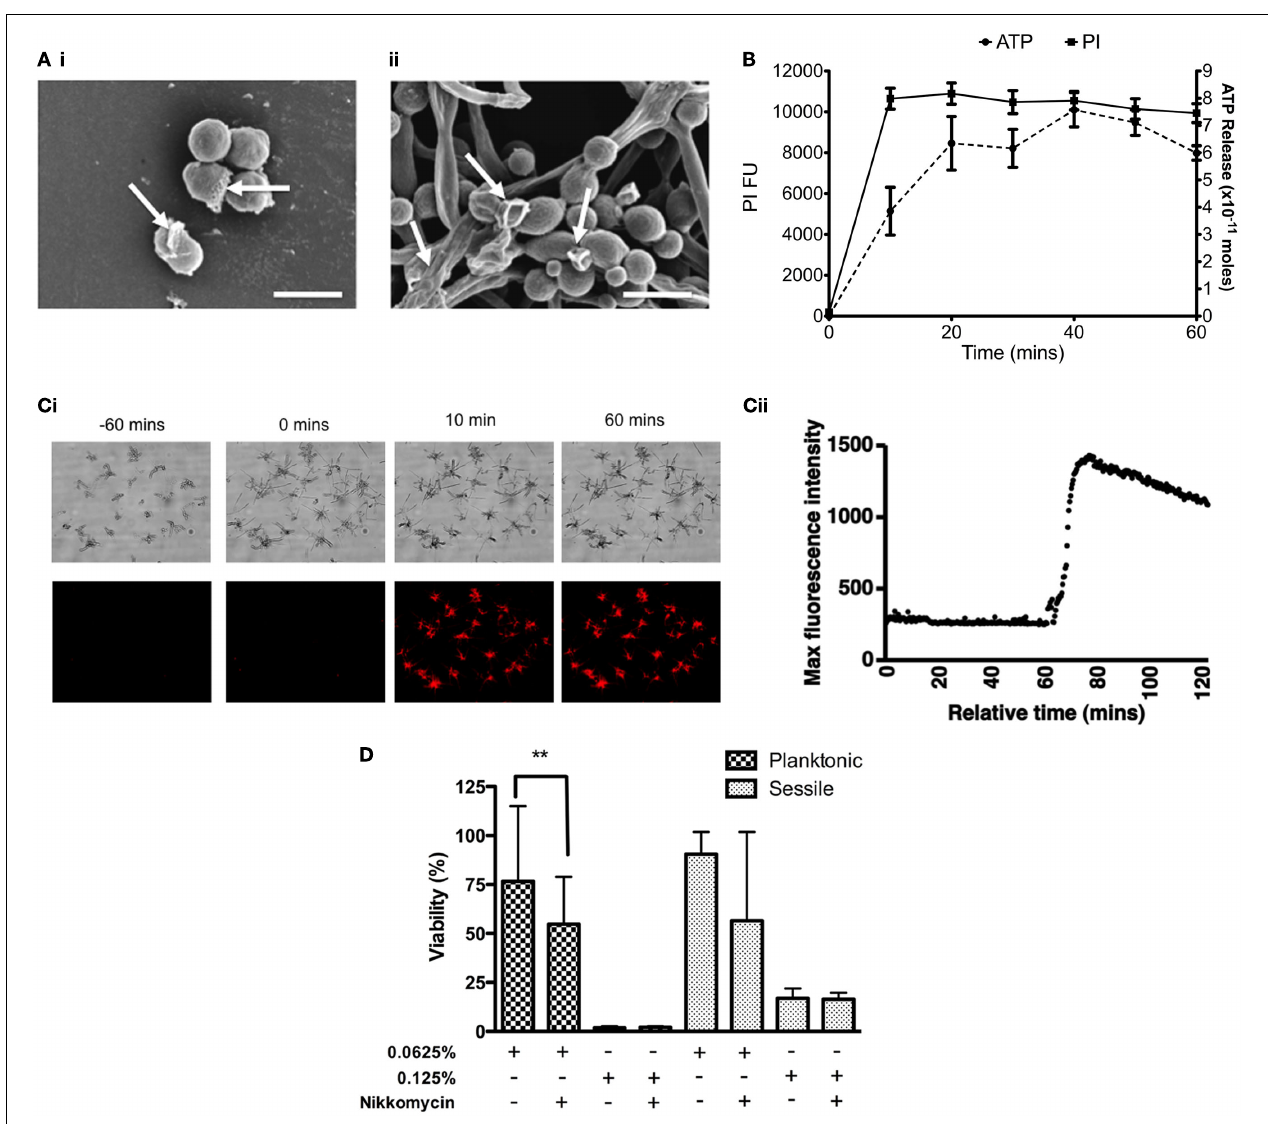
FIGURE 2 | Carbohydrate derived fulvic acid permeabilizes Candida albicans cell membranes. (A) Planktonic cells (i) and sessile (ii) cells were treated at their respective MIC 90 for 24h either in solution or on Thermanox™coverslips, respectively.These were then processed and viewed on a JEOL JSM-6400 scanning electron microscope and images assembled using Photoshop software. Note the apparent disruption of the cell wall denoted by arrows on both the planktonic and sessile cells. Scale bars represent 5 μ m. (B) C. albicans (SC5314) planktonic cells (5 × 10 7 cells/ml) were treated with CHD-FA (4%) for 10, 20, 30, 40, 50, and 60min. A negative control (no CHD-FA) was also included. For PI experiments the cells were washed by centrifugation, resuspended in PI (20 μ M in PBS), and incubated for 15min at 37˚C.These were then transferred to a black 96-well plate for quantification in a fluorescent plate reader (Ex 485 /Em 620 ). For ATP release the cells were removed by filter sterilization (0.22 μ m) and supernatants adjusted to a pH of 7.8 in